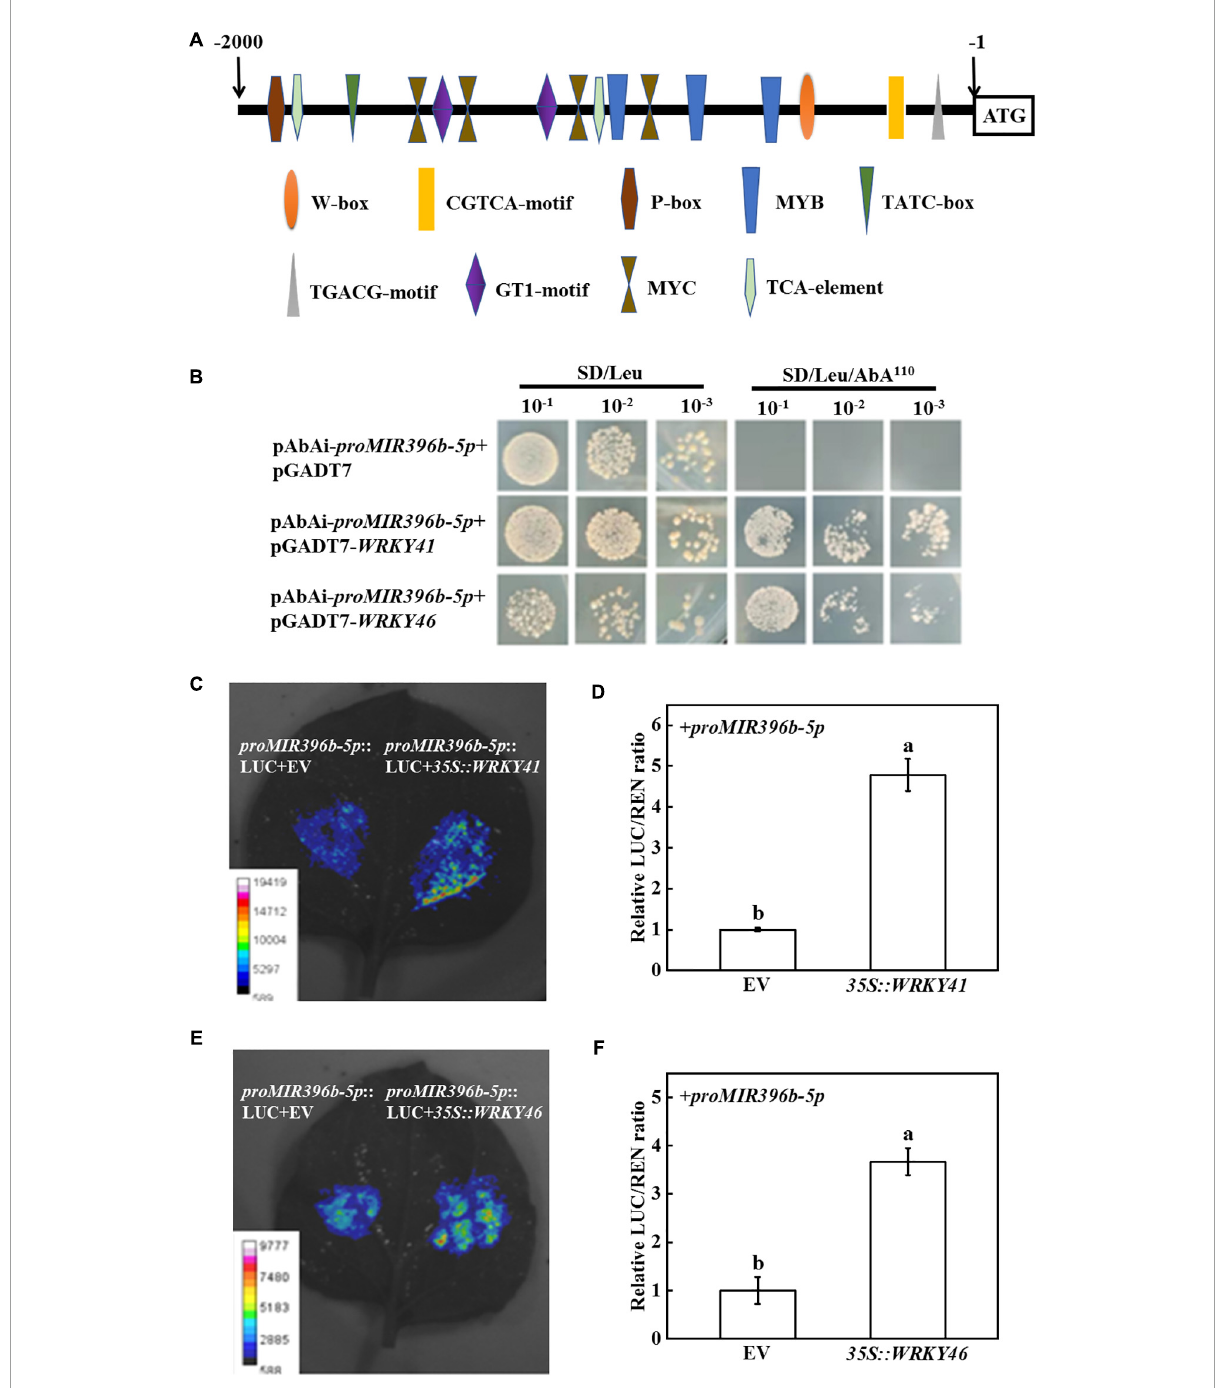
FIGURE5 WRKY 41 and WRKY46 binding to the promoter of MIR396b-5p . (A) Analysis of the cis- acting elements in the promoter of MIR396b-5p . Numbering is from predicted transcriptional start sites. (B) Yeast one-hybrid assays indicating WRKY41 and WRKY46 binding to the promoter of MIR396b-5p . Yeast cells with DNA-protein interactions were grown on SD/Leu plates with 110 ng mL − 1 aureobasidin A. (C,D) Dual-luciferase assay showing transient overexpression of WRKY41 increase the expression of MIR396b-5p in Nicotiana benthamiana leaves. (E,F) Dual-luciferase assay showing transient overexpression of WRKY46 increase the expression of MIR396b-5p in N. benthamiana leaves. Agrobacterium tumefaciens harboring the indicated plasmids were infiltrated into tobacco leaves, and the leaves were analyzed after infiltration for 2 d. The empty vector was used as a control. The results represent the mean ± SD ( n = 3). Means with the same letter did not significantly differ at P < 0.05 according to Tukey’s test. EV, empty